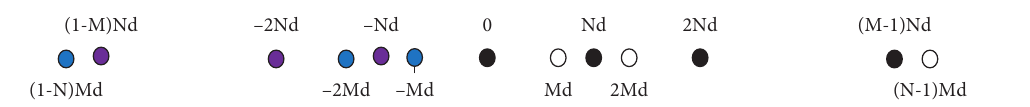
Figure 4: The structure of the symmetric coprime array, where the white and black array elements are the real elements of the two subarrays and the blue and purple array elements are the virtual array elements corresponding to the real array elements.